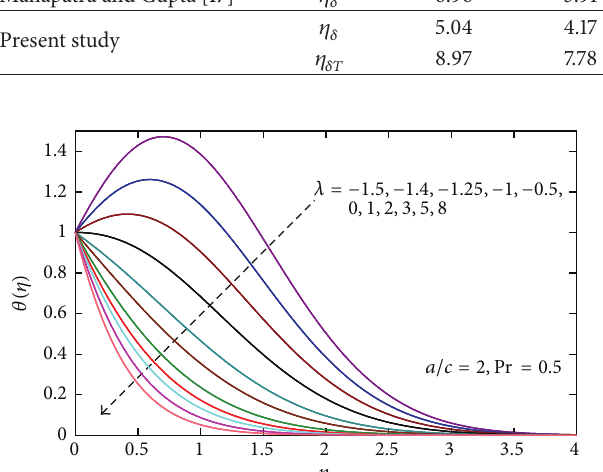
Figure 7: Temperature gradient profiles 𝜃 󸀠 (𝜂) for various values of 𝜆 with 𝑎/𝑐 = 2 .